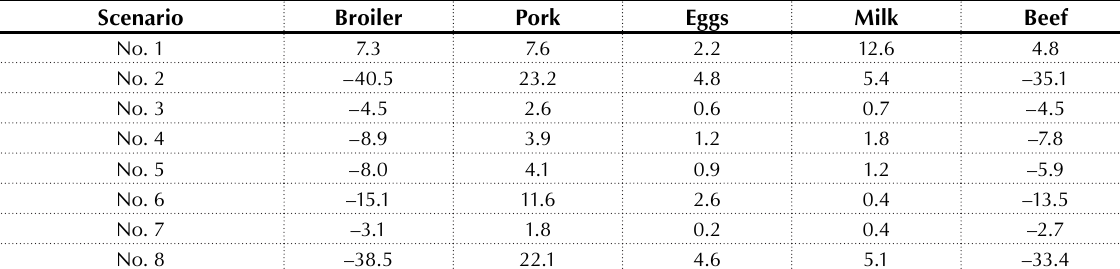
Source: Calculated by the authors.